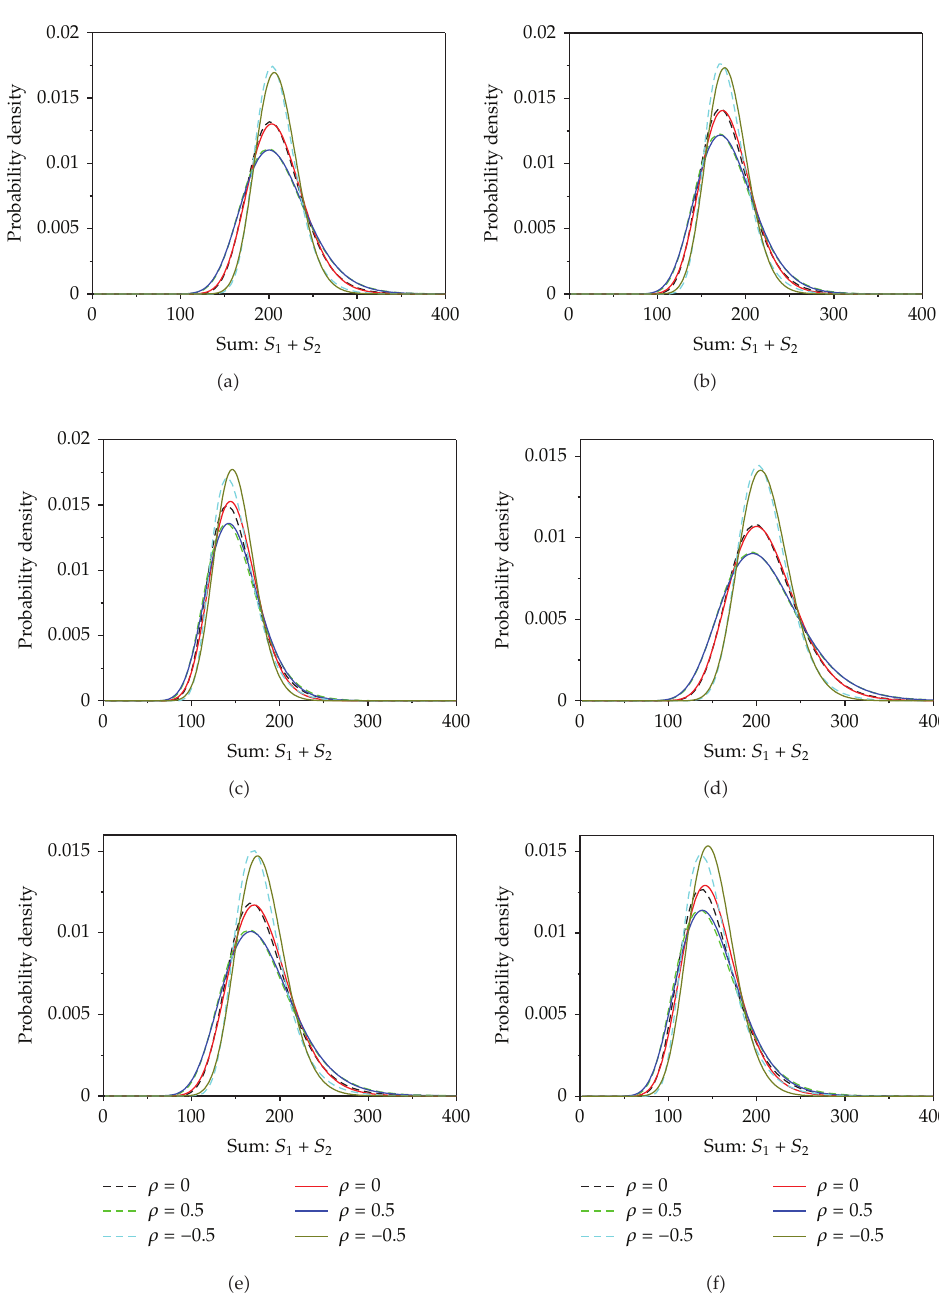
Figure 1: Probability density versus S 1 (cid:8) S 2 : The solid lines denote the distributions of the approximate shifted lognormal process, and the dash lines show the exact results. (cid:3) a (cid:4) S 10 (cid:7) 110, S 20 (cid:7) 100, σ 1 (cid:7) 0 . 25, and σ 2 (cid:7) 0 . 15; (cid:3) b (cid:4) S 10 (cid:7) 110, S 20 (cid:7) 70, σ 1 (cid:7) 0 . 25, and σ 2 (cid:7) 0 . 15; (cid:3) c (cid:4) S 10 (cid:7) 110, S 20 (cid:7) 40, σ 1 (cid:7) 0 . 25, and (cid:7) 0 . 15; (cid:3) d (cid:4) S (cid:7) 110, S (cid:7) 100, σ (cid:7) 0 . 3, and σ (cid:7) 0 . 2; (cid:3) e (cid:4) S (cid:7) 110, S (cid:7) 70, σ (cid:7) 0 . 3, and σ (cid:7) 0 . 2; (cid:3) f (cid:4) σ 2 10 20 1 2 10 20 1 2 S (cid:7) 110, S (cid:7) 40, σ (cid:7) 0 . 3, and σ (cid:7) 0 . 10 20 1 2